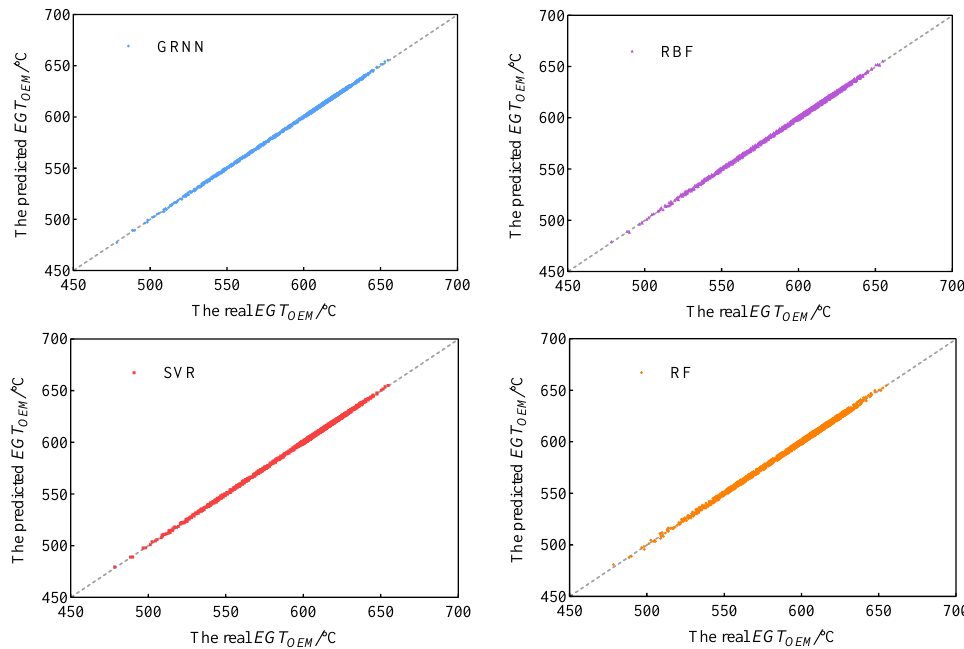
Figure 8. Prediction output of different models based on training data.